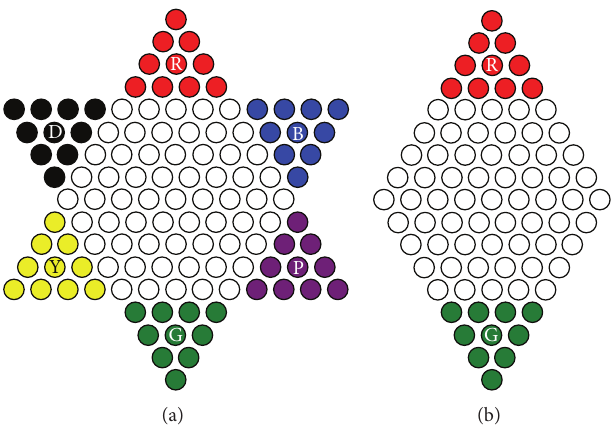
Figure 9: Chessboard. (a) The traditional chessboard. (b) The simplified chessboard without the useless star corners.